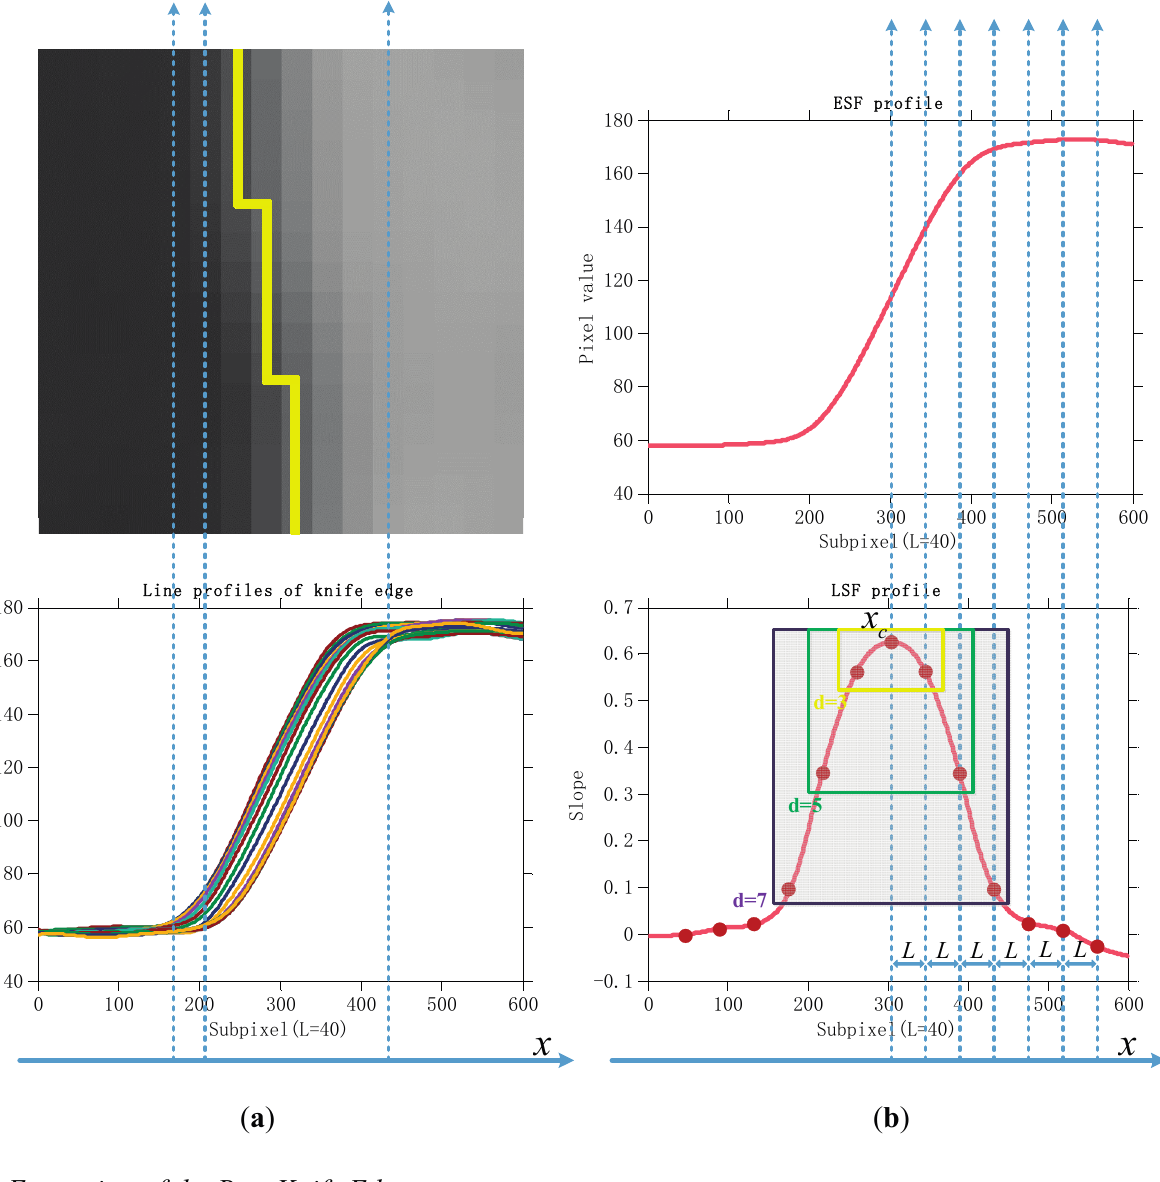
Figure 2. Example of LSF estimation: ( a ) comparison of the knife edge and its line profiles after interpolation; ( b ) ESF and LSF profiles at the subpixel level and a sample example of the LSF ( L is the value interpreted between each data pair; center of the LSF; d is the different candidate LSF